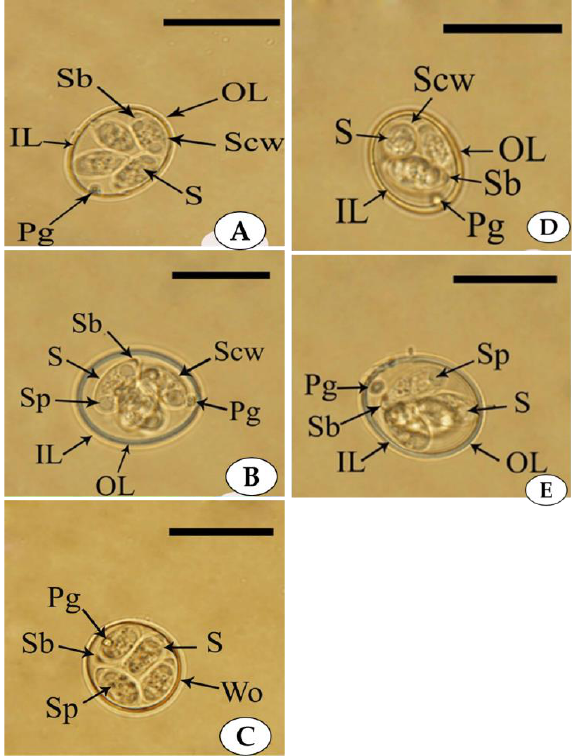
Figure 2. Photomicroscope images showing the sporulated oocysts of E. maxima ( A ), E. tenella ( B ), E. acervulina ( C ), E. praecox ( D ), and E. necatrix. ( E ) The outer (OL) and the inner (IL) layers of the oocyst wall, as well as the polar granule (Pg), sporocyst (S), Stieda body (Sb), sporocyst wall (Scw), sporozoite (SP), showing the presence of four sporocysts containing two sporozoites in each sporocyst (scale per = 20 μm).